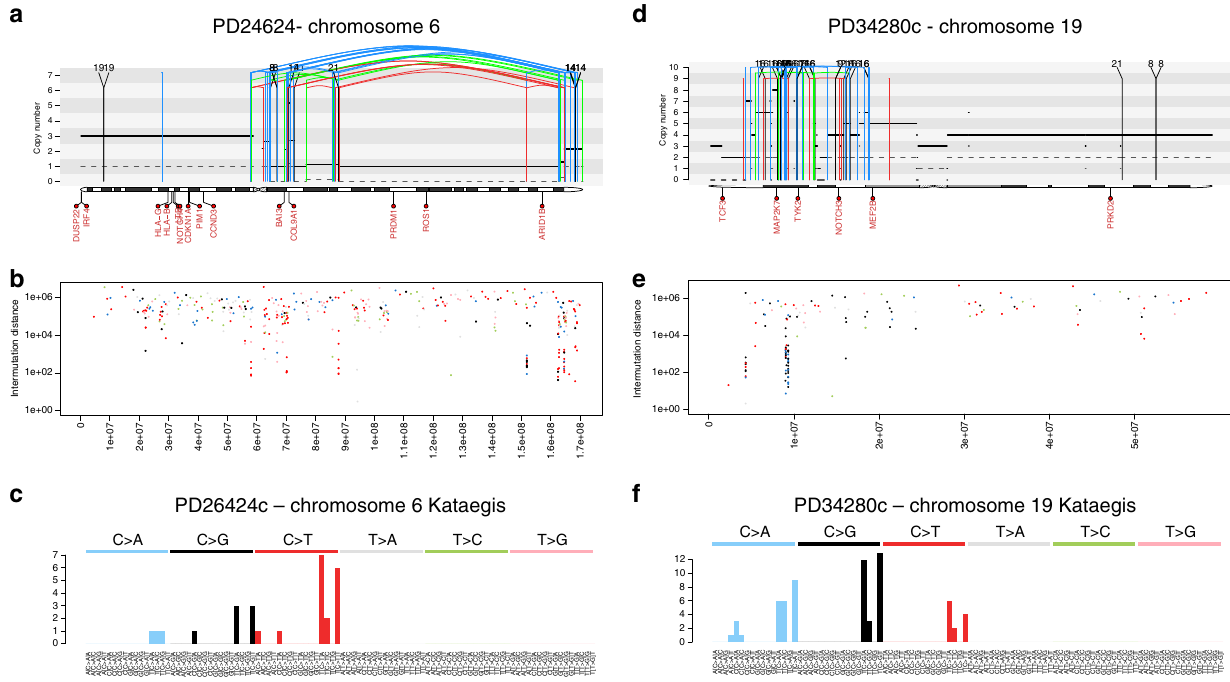
Fig. 5 Kataegis in hematological malignancies. a Example of a MM patient with a chromothripsis on chromosome 6 associated with APOBEC-mediated kataegis. The solid and dashed lines re fl ect the total ploidy and the copy number status of the minor allele, respectively. In these plots, the red arch represents a deletion, the green arch represents a tandem duplication and the blue arch represents an inversion. b Inter-mutational distance of all mutations in chromosome 6, color-coded by mutational class. c Ninety-six-mutational classes of all kataegis events on chromosome 6. d Chromothripsis event on chromosome 19 in a therapy-related AML. e Inter-mutational distance of all mutations across chromosome 19. f Ninety-six-mutational classes of all mutations involved in the chromosome 19 kataegis: APOBEC emerged as the dominant mutational process, despite its activity was not detectable across the genome (Supplementary Software File